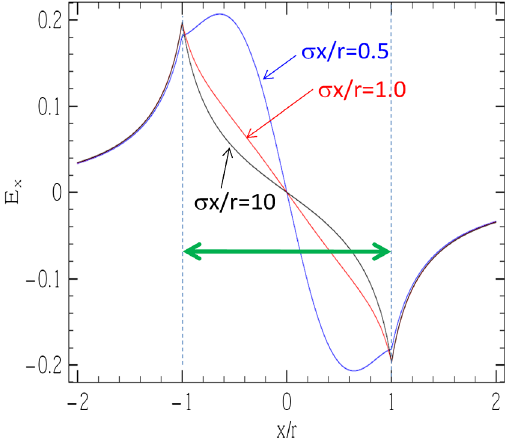
FIG. 3. Transverse space charge force for different transverse laser profiles on the cathode (by varying (cid:2) x =r ). The black line corresponds to a uniform spatial profile, the red and blue represent different truncated-Gaussian spatial profiles. The result in the red one is the most linear. transverse iris instead of a round one, provides a qualitative understanding of the simulation results.